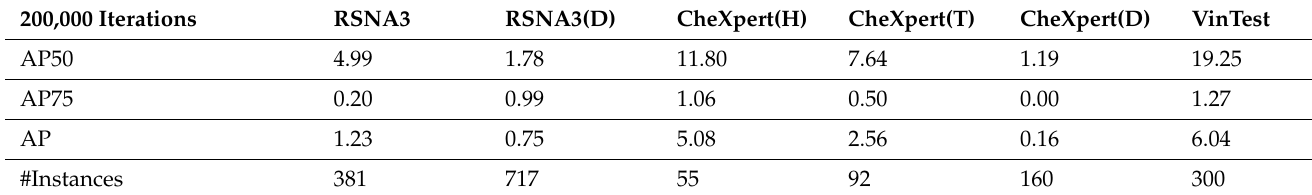
Table 3. Pneumonia detection training on VinBig.